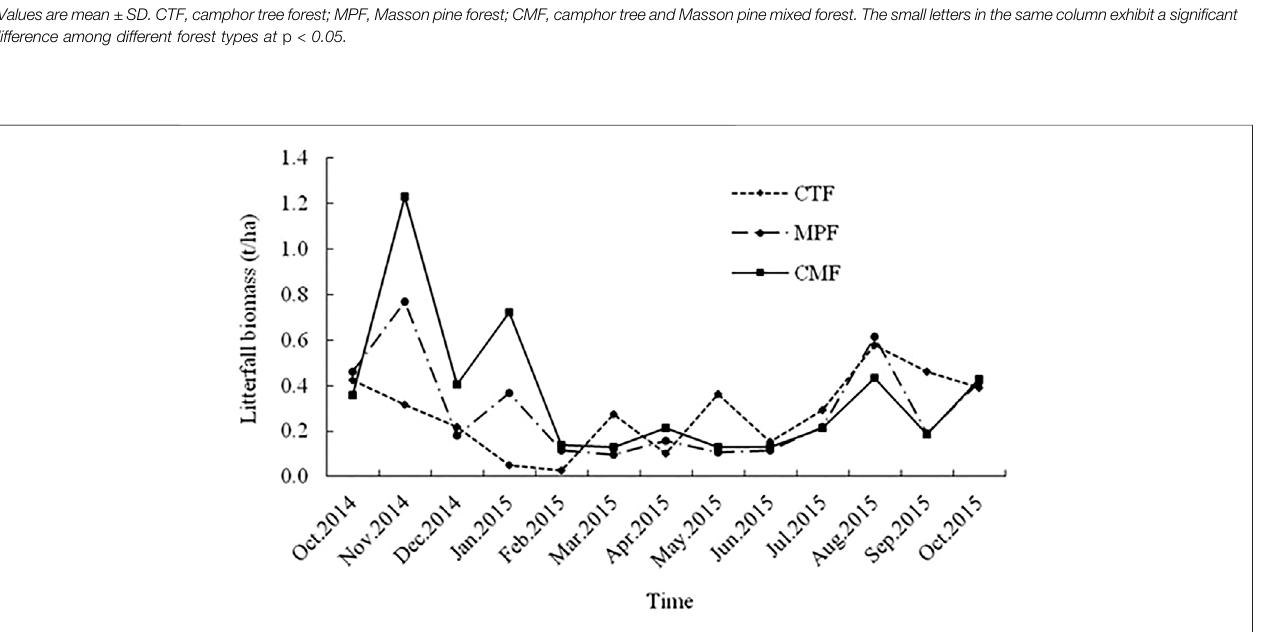
Frontiers in Environmental Science |